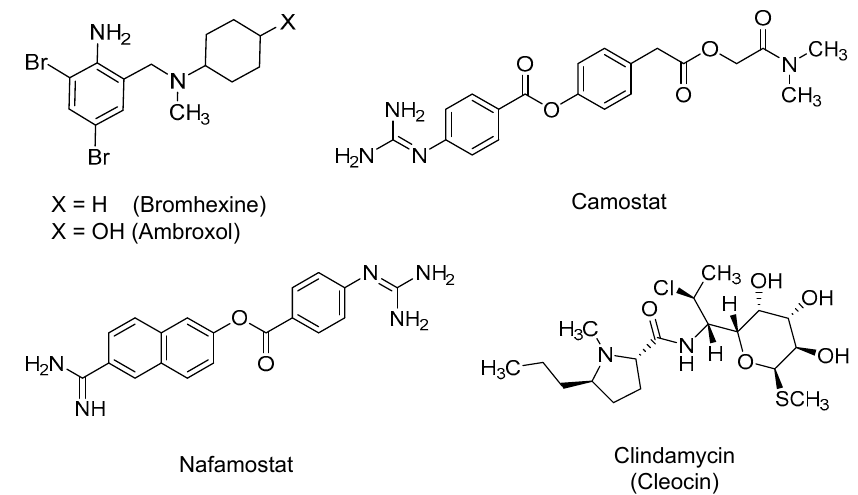
Figure 5. The chemical structures of TMPRSS2 inhibitors that are being tested in clinical trials for COVID-19 patients. The listed drugs potentially prevent the viral fusion with the host cell.